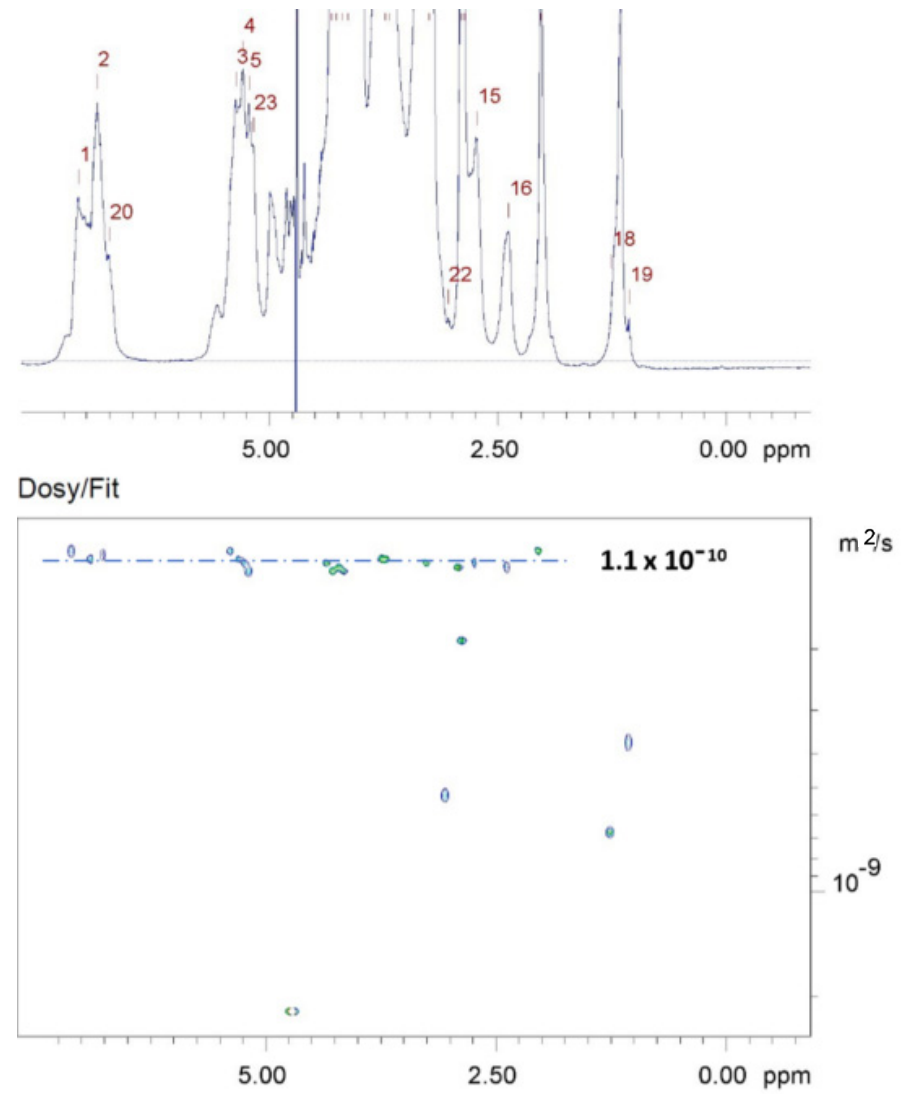
Figure 2. DOSY spectrum of DA-LMWH. The polymer protons align at 1.1 × 10 − 10 m 2 s -1 . The free EDC protons show a faster